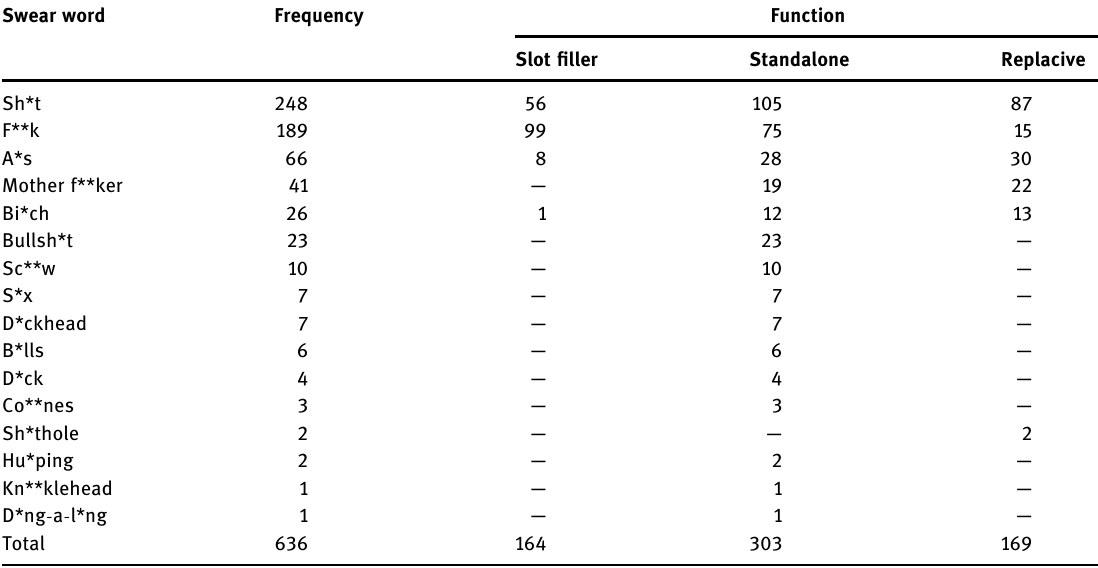
Table 5: Swear word frequencies and functions